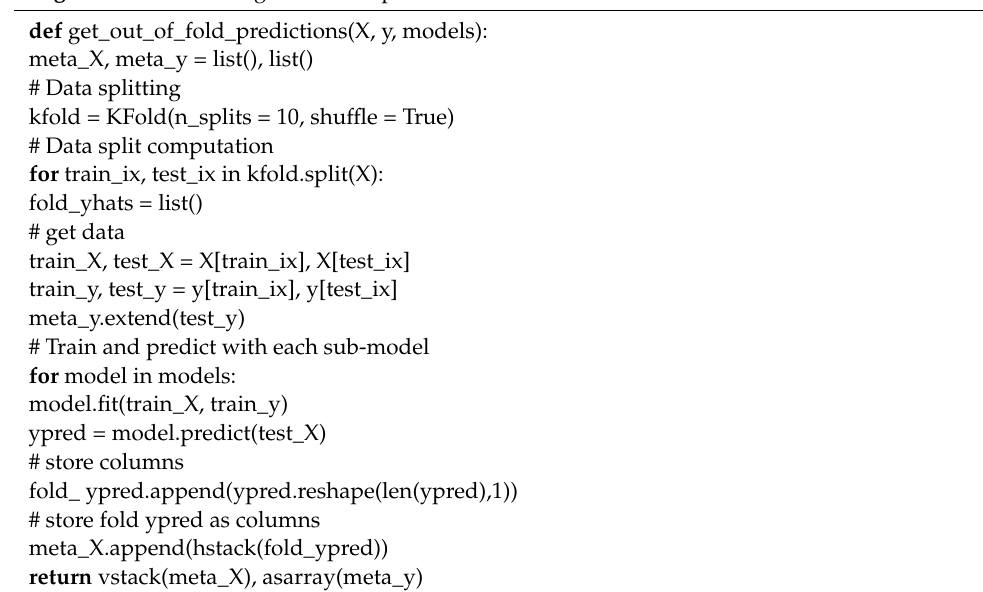
Algorithm 2 is about collecting out of fold predictions from K-fold cross-validation to create meta model dataset to train and test the Deep Ensemble Super Learner [56]. Algorithm 2: Collecting out of fold predictions from k-fold